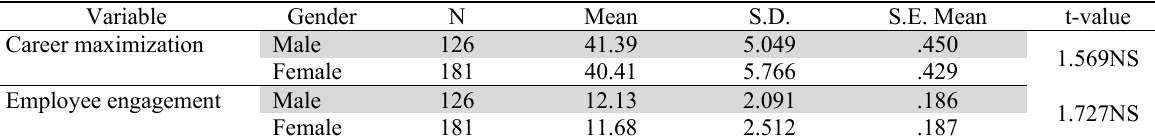
Data and value for